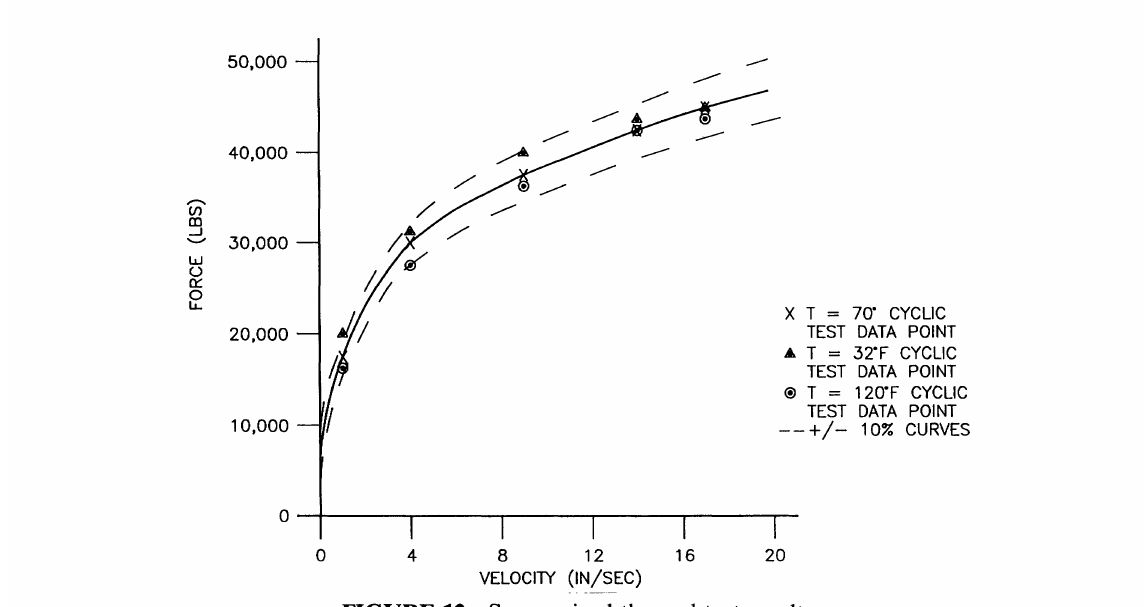
FIGURE 12 Summarized thermal test